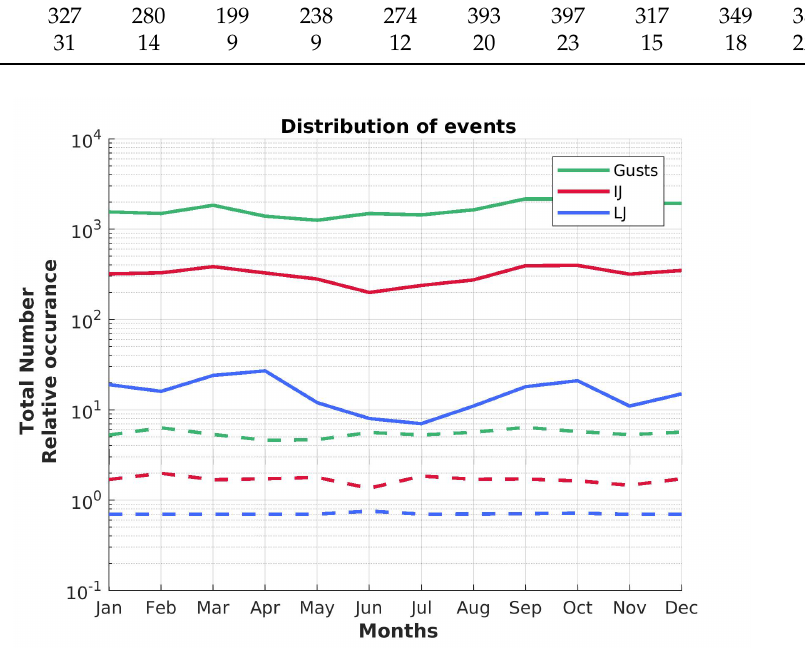
Figure 10. Number of events for gusts, intermediate and long jets summed up over all years for every month (solid line). The dashed lines represent the relative occurrence of these three events in respect to the absolute number of measurement points per